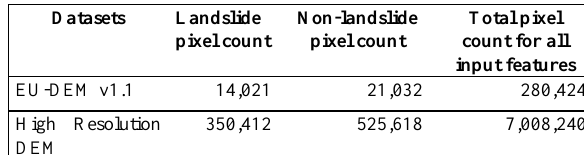
Table 6. The number of landslide and non-landslide pixels in both training